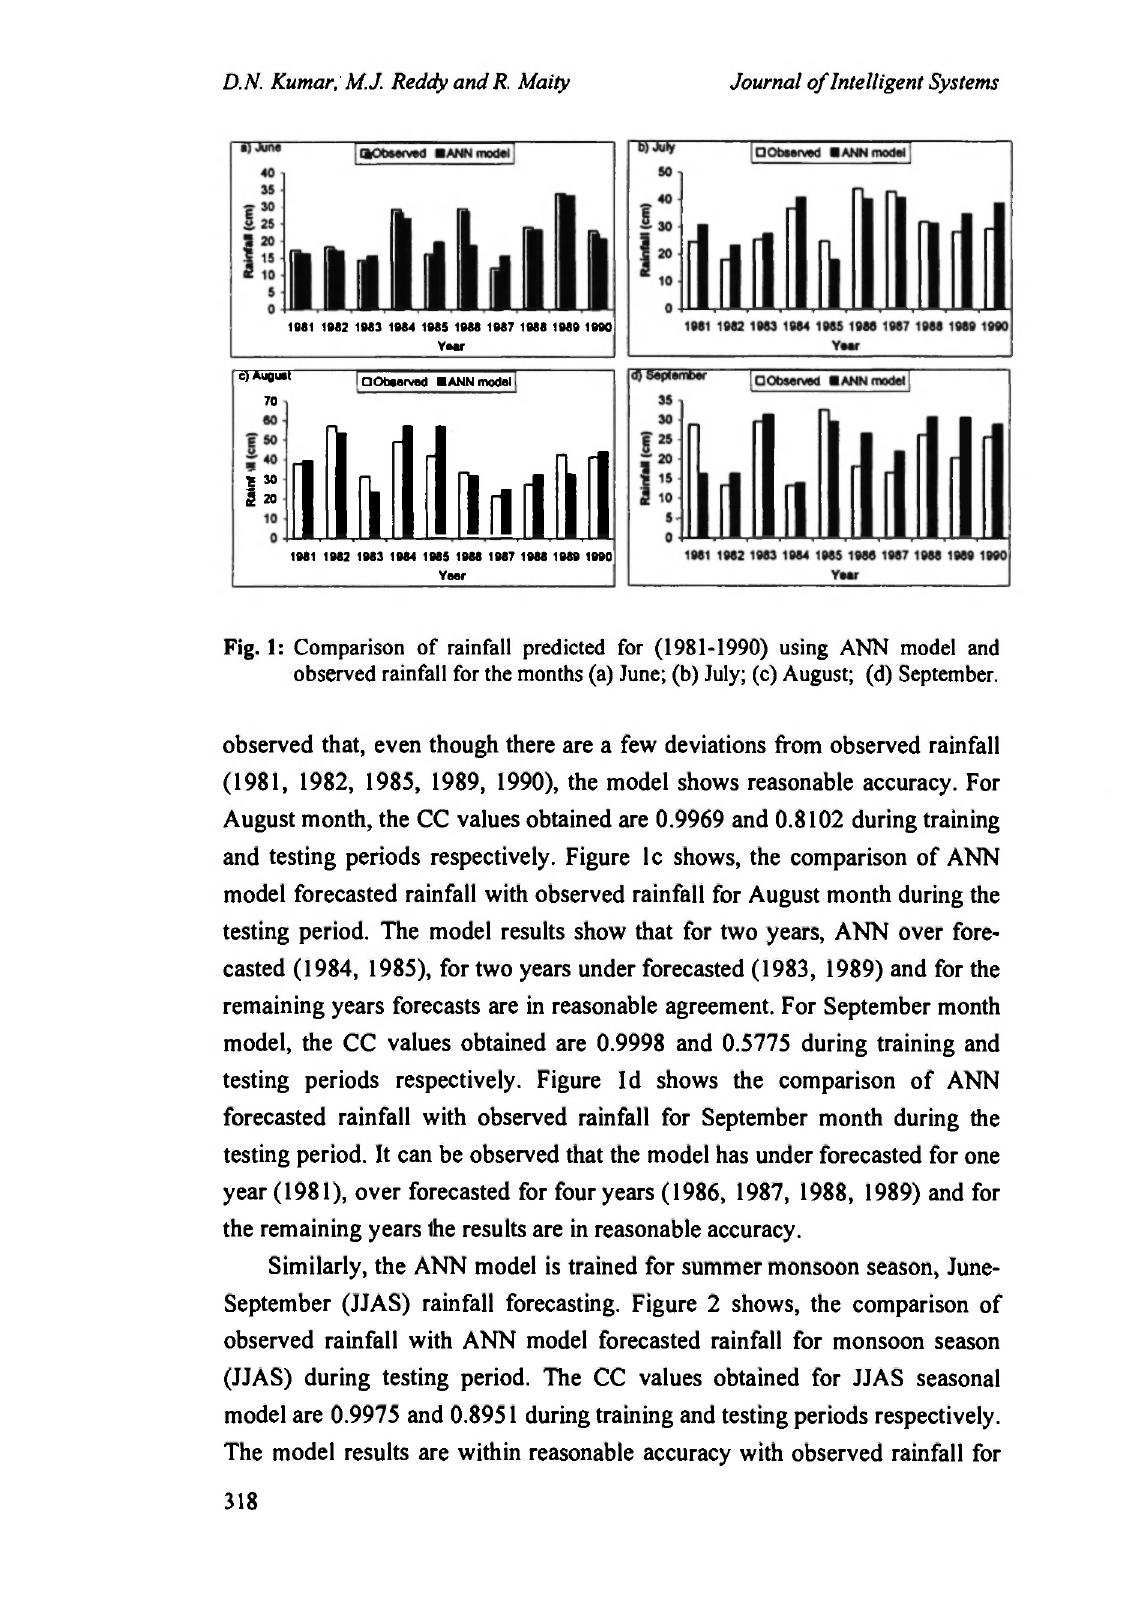
Fig. 1: Comparison of rainfall predicted for (1981-1990) using ANN model and observed rainfall for the months (a) June; (b) July; (c) August; (d)